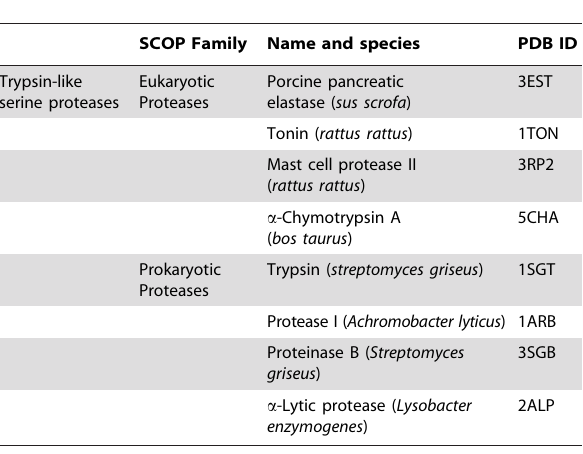
Table 1. Details of Serine proteases used in structural alignment and